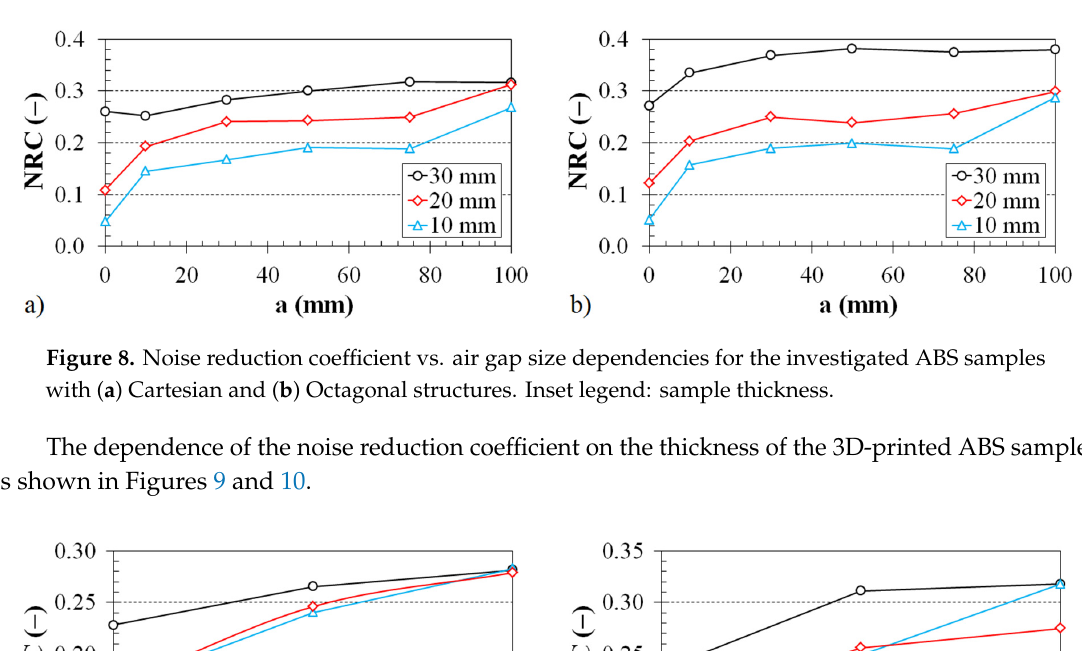
Figure 9. Effect of the material structure on the noise reduction coefficient vs. the material thickness dependencies for the investigated ABS samples placed at a distance from the wall inside the impedance tube: ( a ) 30 mm and ( b ) 75 mm.